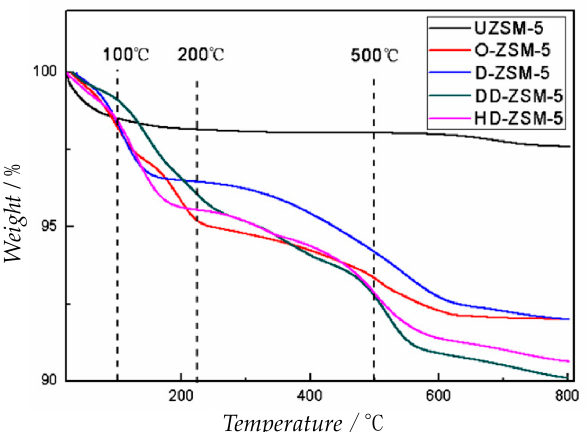
Figure 7. Weight-loss profile of chlorosilane modified ZSM-5 adapted from Reference [62] (O = octyltrichlorosilane, D = decyltrichlorosilane, DD = dodecyltrichlorosilane, HD = hexadecylthriclorosilane). The major water loss is experimented by the bare UZSM-5. As showed, the decomposition of chlorosilane happens in the range of 500 °C, a higher temperature than the silane boiling point (from 233 °C to 269 °C).